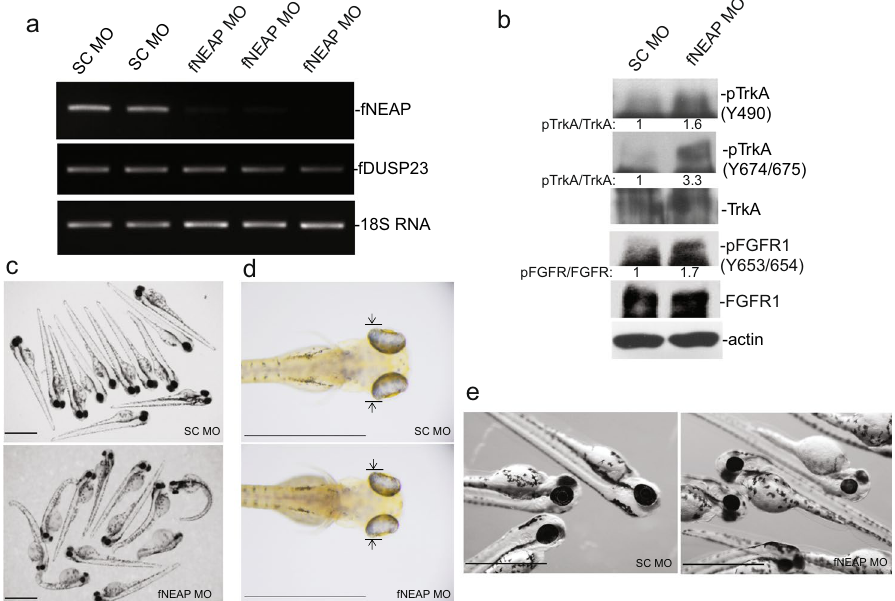
Figure 6. Suppression of NEAP expression in zebrafish causes biochemical and morphological abnormalities. ( a ) Zebrafish fertilized eggs were injected with a morpholino (MO) against fNEAP or a corresponding control MO with scrambled sequence (SC). The expression of fNEAP, fDUSP23, and 18S RNA at the 72-hpf time point were examined by RT-PCR. ( b ) Fish embryos treated with SC or fNEAP MO were subjected to extract preparation and immune-blotting analyses using the indicated antibodies. ( c ) General abnormality of zebrafishes with MO treatments at the 72-hpf time point. ( d ) Head widths of MO-injected zebrafish were measured as indicated by the arrows. ( e ) Smaller eyes and heads in fNEAP MO-treated zebrafishes. Twelve MO- injected fishes from each group were randomly selected for measuring the head and eye sizes. Scale bars: 1